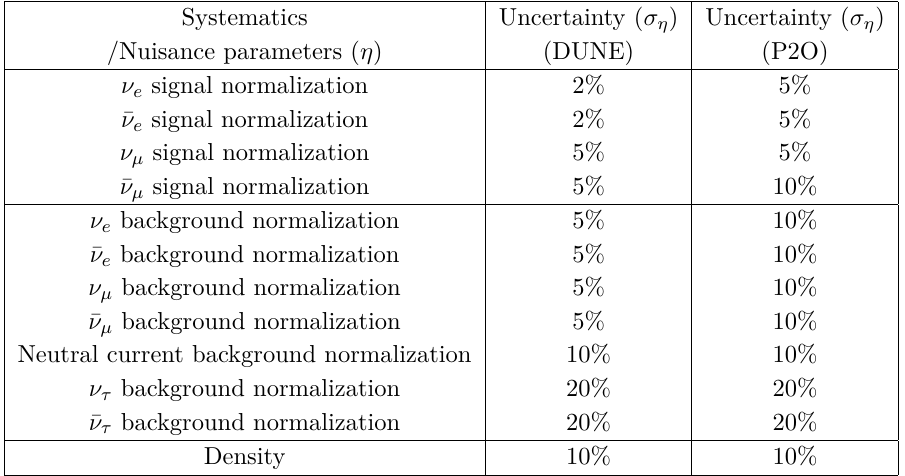
Table 2 . The signal/ background systematics and the density uncertainties used in our analysis for both DUNE and P2O